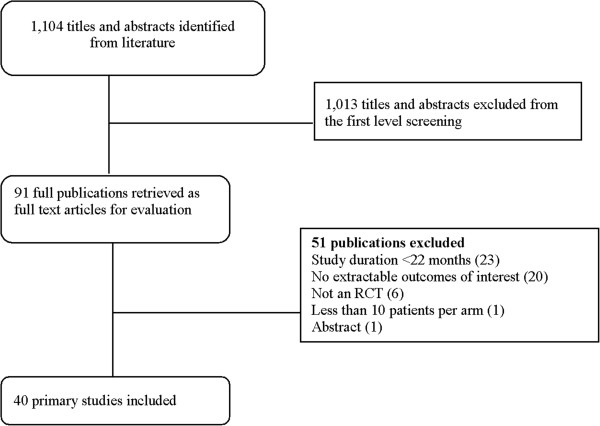
Study attrition.